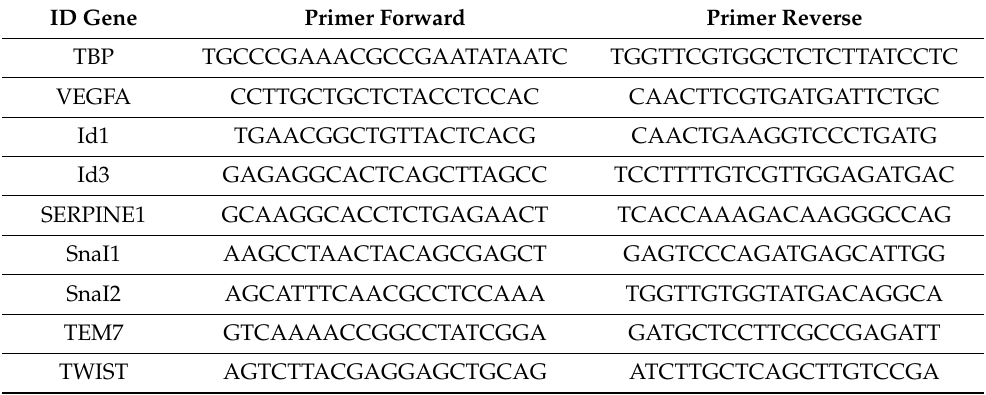
Table 1. Real-time PCR primer